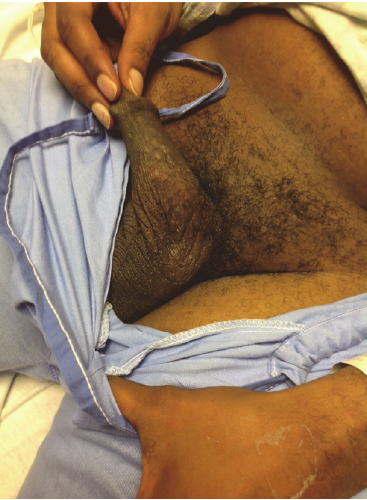
Figure 3: Photograph demonstrating a maculopapular rash dis- tributed on the shaft of